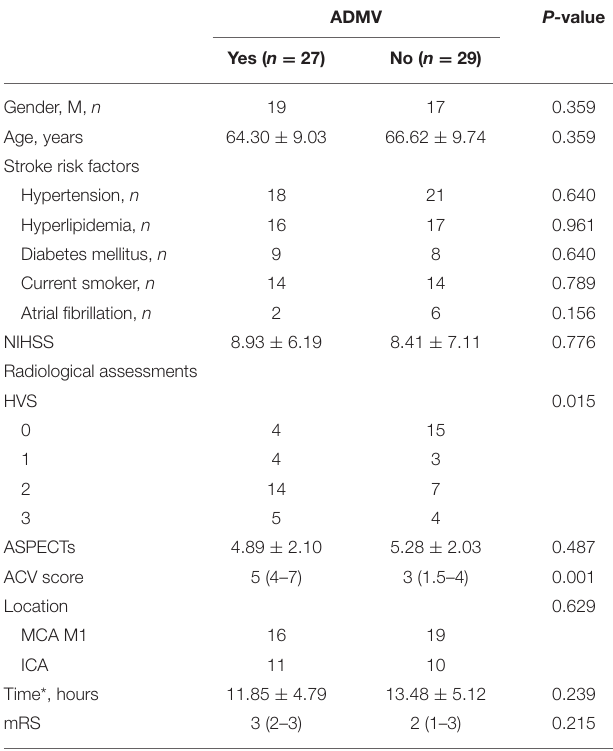
TABLE 1 | Univariate analysis of factors related to presence of ADMV in patients with occlusion of a large cerebral